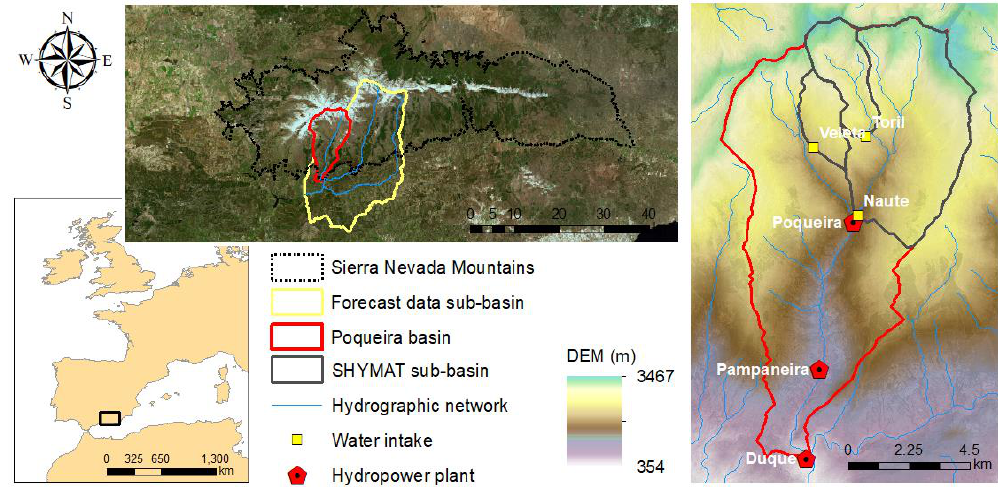
Figure 1. Location of the Poqueira River basin in southern Spain and the three run of river (RoR) plants system in the pilot area. The sub-basin where seasonal forecast data are produced and the sub-basins defining the three different points of water uptake for the hydropower production (SHYMAT (small hydropower management and assessment tool) sub-basins) are also presented (from Contreras et al. [5]).